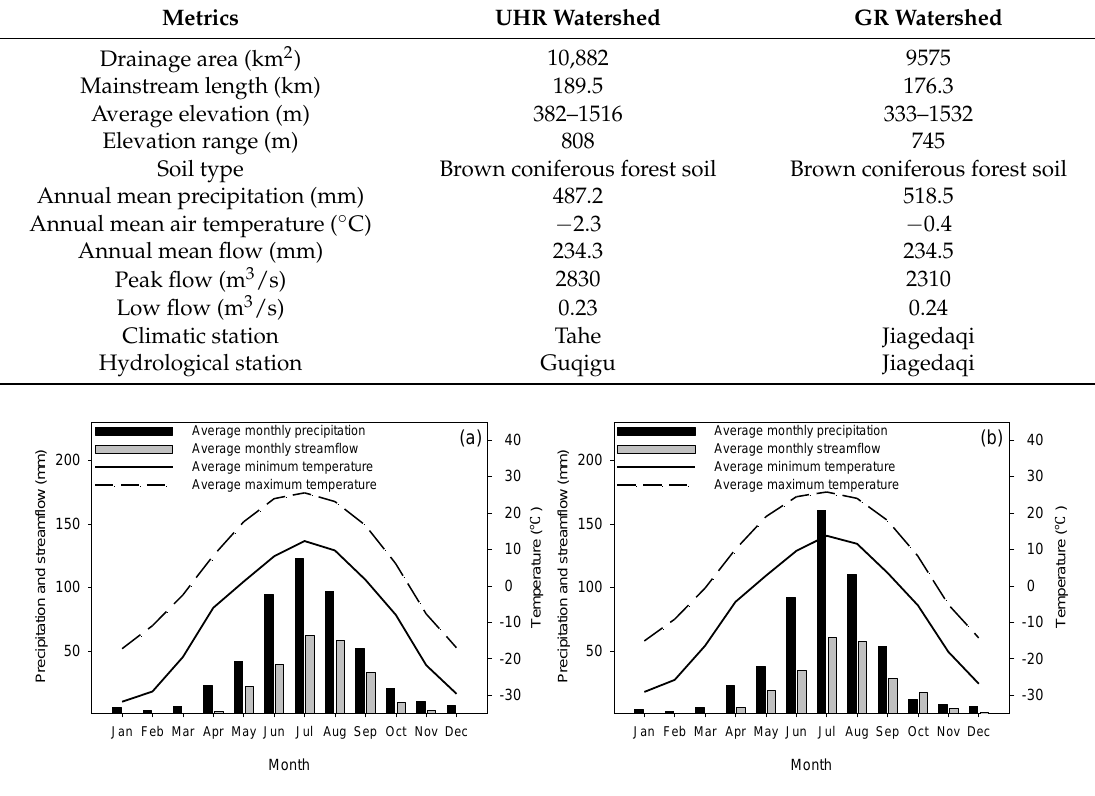
Figure 2. Average monthly precipitation, streamflow, minimum and maximum air temperature in the UHR ( a ) and GR ( b ) watersheds from 1975 to 2013.